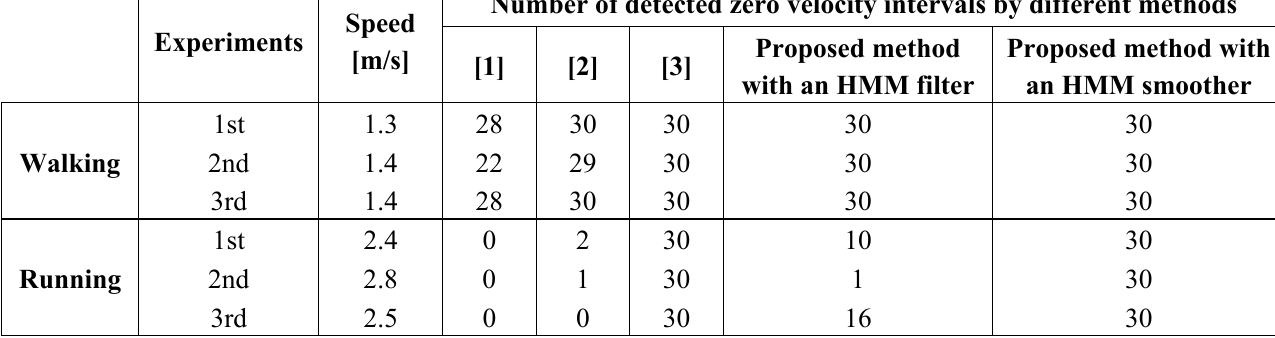
Table 2. Number of detected zero velocity intervals by different methods (actual number of zero velocity interval is 30).